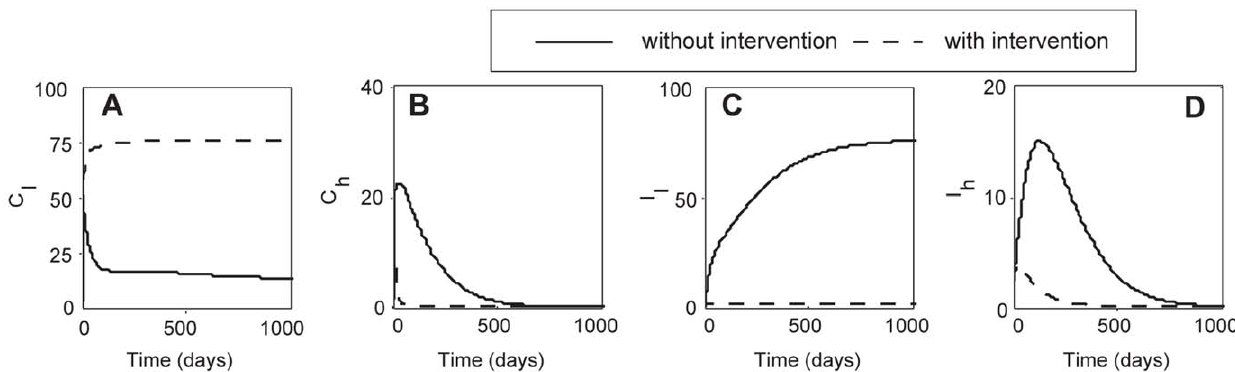
Figure 4. Baseline steady state analyses before and after combined intervention strategies ( m c= 1 and h h= 1) (A–D). (A) TTG colonization ( C l ). The colonization rate of TTG is greatly reduced but not eliminated. Additional intervention, cross-immunity, is required to completely clear TTG colonization. (B) VTG colonization ( C h ). VTG colonization is eliminated faster after intervention. However, VTG colonization can be reduced in absence of intervention by competitive exclusion. (C). TTG infection ( I l ) is eliminated after combined intervention. (D) VTG infection ( I h ) is eliminated with intervention but can also go extinct through time as a result of competitive exclusion in absence of intervention. These analyses do not include admission of colonized or infected patients.